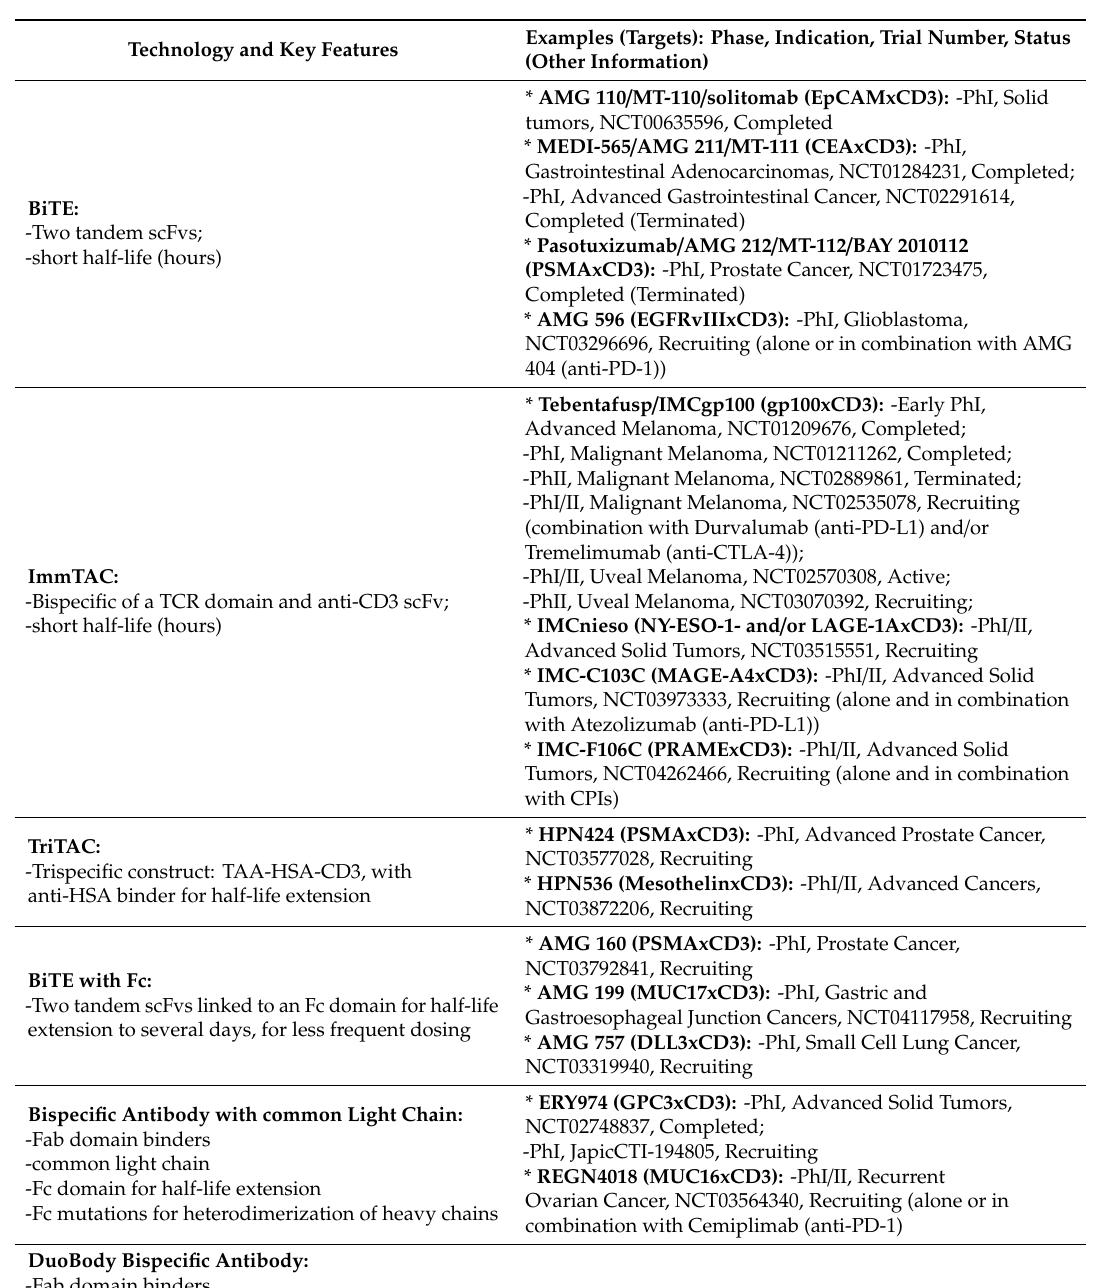
Table 1. Bispecific technologies and examples of specific T-cell Engager molecules in clinical trials for solid tumors. Features are derived from literature as described in the main text. Information on molecules and clinical trials is from clinicaltrials.gov and from Citeline. Of the 68 clinical trials in Figure 1, the molecules included in this table have clinical trial numbers assigned. The bispecific antibodies catumaxomab and ertumaxomab, for which all clinical trials are closed, are not